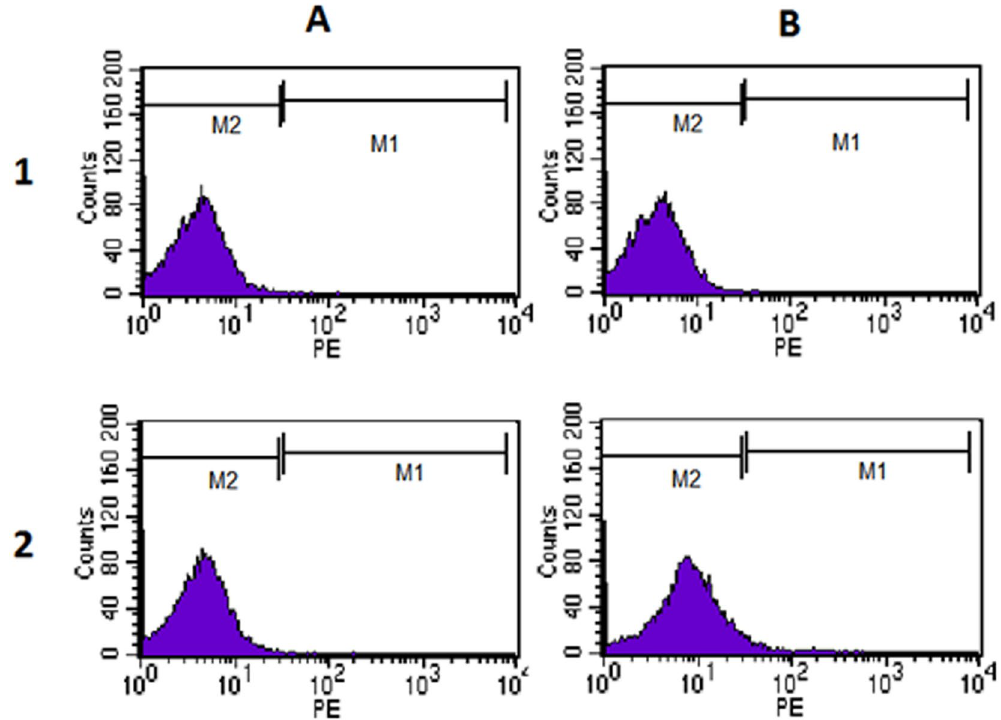
Figure 3. Activated Caspase-3 expression in cumulus granulosa cells by flow cytometry. ( A ) PBS serves as the primary antibody; ( B ) Positive expression of activated Caspase-3. 1, Non-pregnant group; 2, Pregnant